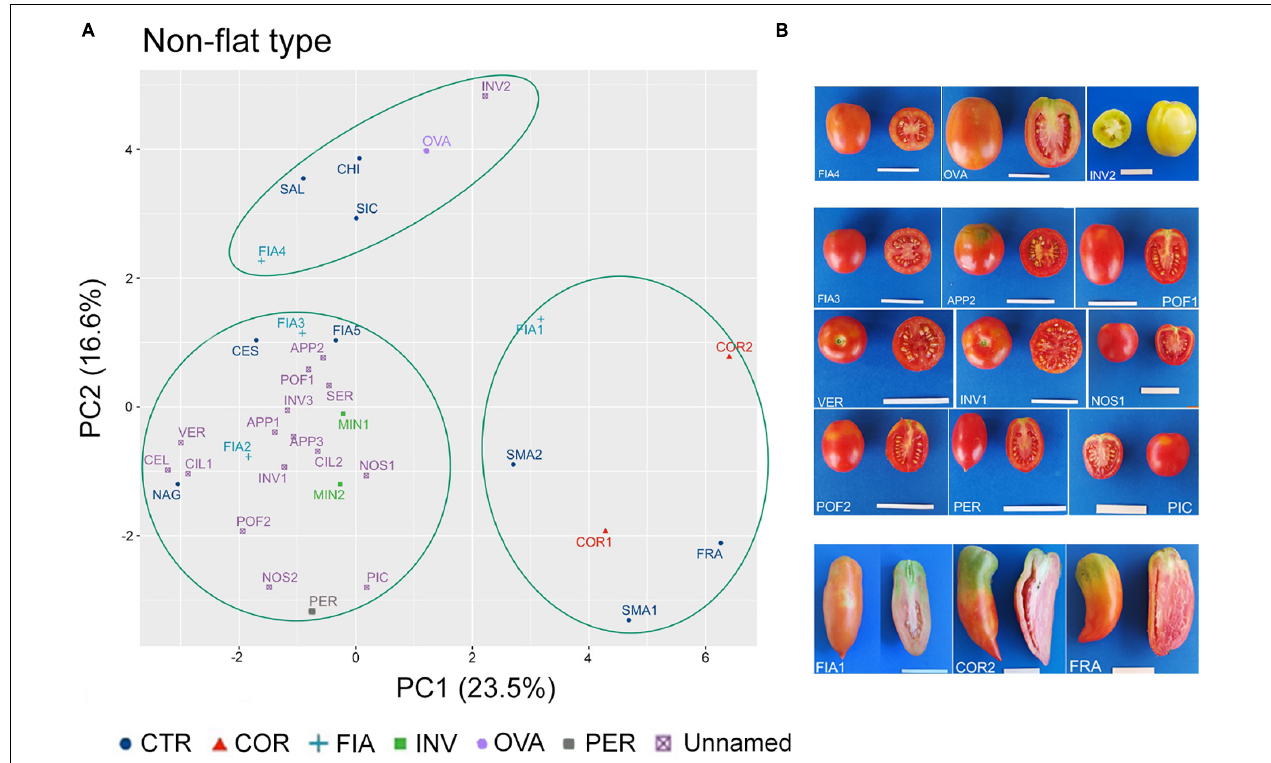
FIGURE 7 | Phenotypic variability of the 35 tomato genotypes included in the non-flat-type group. (A) Scatter plot of the first (PC1) and second (PC2) principal components showing the variation of 15 quantitative and ten qualitative vegetative and reproductive traits in the 35 accessions included in the non-flat-type group. Accessions are represented by different colored symbols as indicated in the legend; abbreviations are listed in Supplementary Table 1 . (B) Pictures of whole and cross section fruit of representative accessions included in each of the three clusters identified by the PCA. Scale bar is 5